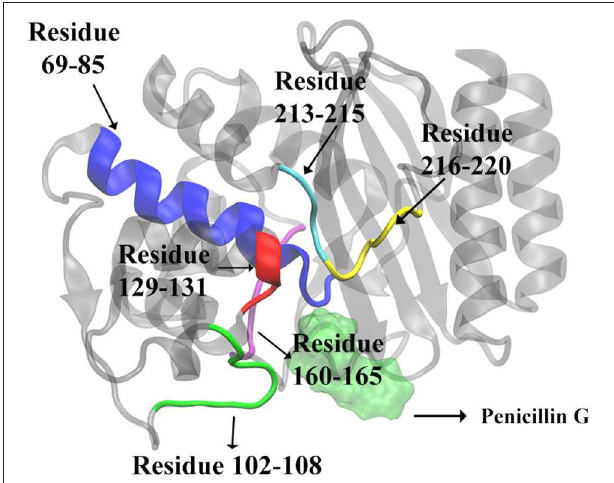
FIGURE 7 | The secondary structures of TEM-1 with significant total feature importance. Residues 69 through 85 as α -helix (blue), residues 213 through 215 as random coil (cyan); residues 216 through 220 as turn (yellow); Residues 129 through 131 as random coil (red), residues 102 through 108 as turn (green), residues 160 through 165 as random coil (purple). The ligand penicillin-G molecule is also illustrated as green transparent surface. The residue 160–165 is behind of the residue 69–85 in this view.